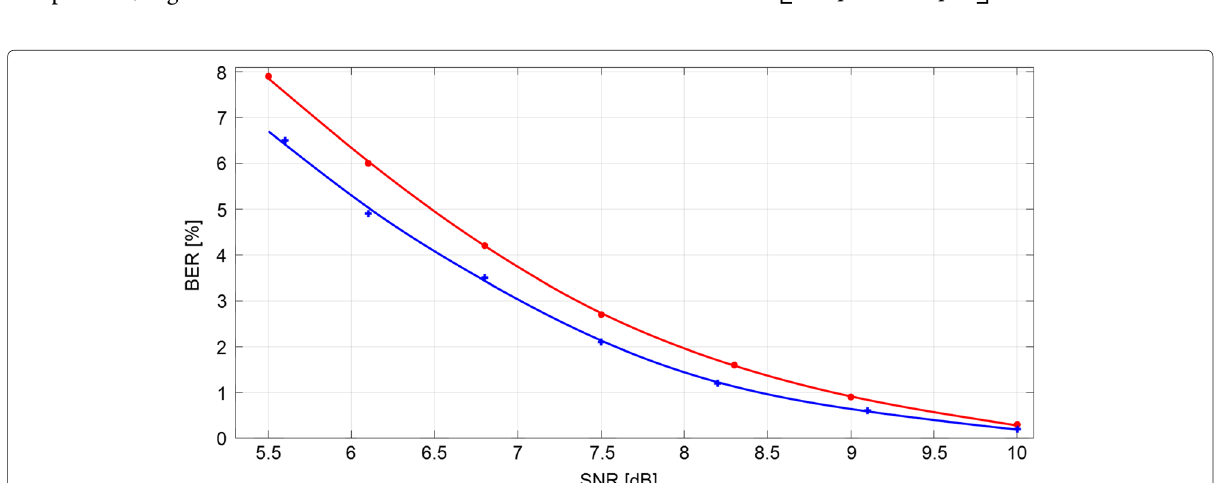
Fig. 2 Perfect reconstruction process: BER vs.